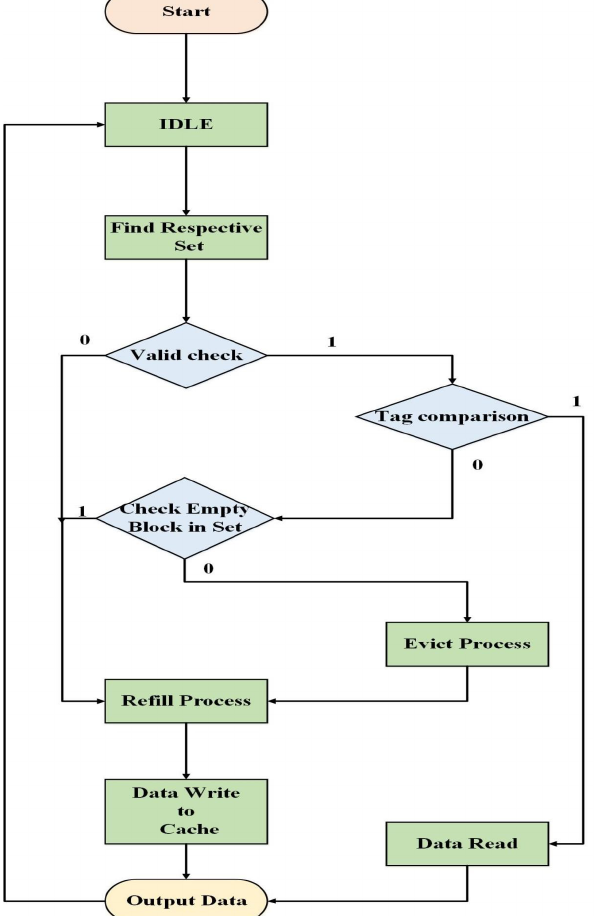
Figure 14. Flow chart diagram of set-associative cache technique for cache hit and